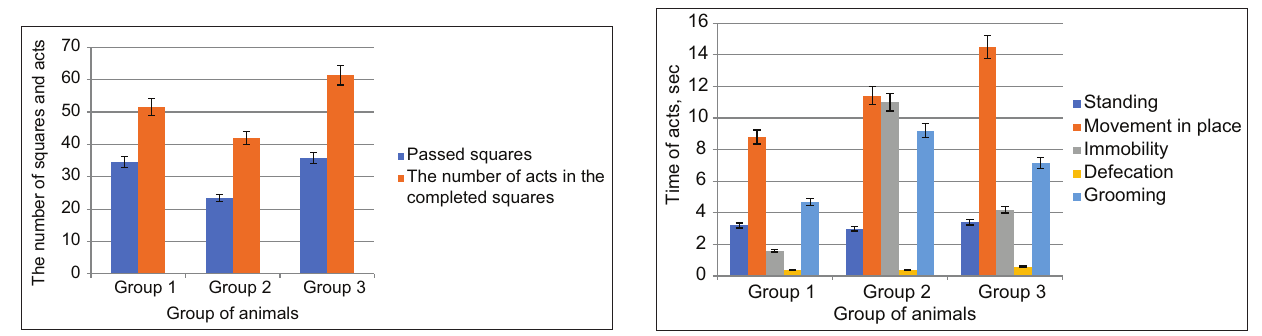
Figure-5: Changes in the time of acts of research and emotional activity when exposed from Samsung Galaxy J1 Mini and Xiaomi Redmi S2